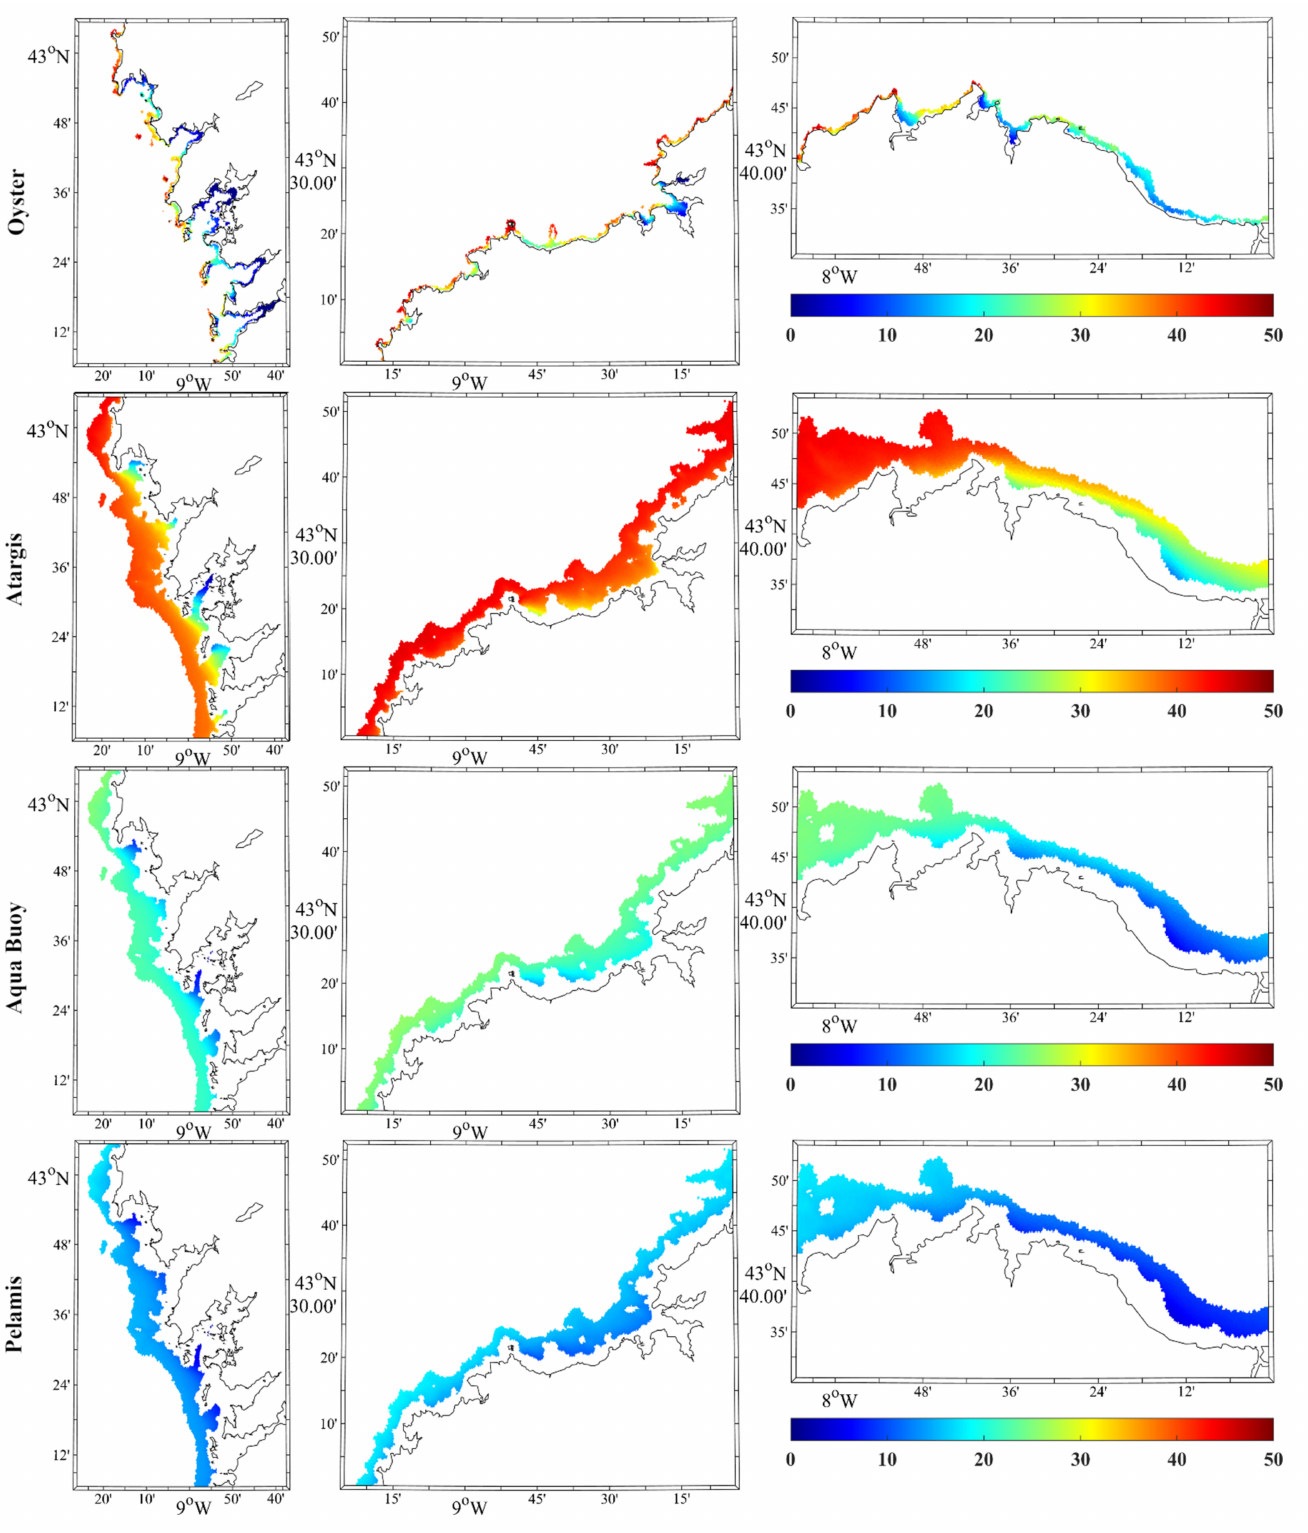
Figure 5. Power load factor ( ε , in %) of the Oyster, Atargis, Aqua Buoy, and Pelamis devices for the West Coast ( left column), the Northwest Coast ( middle column), and the North Coast ( right column) for the period